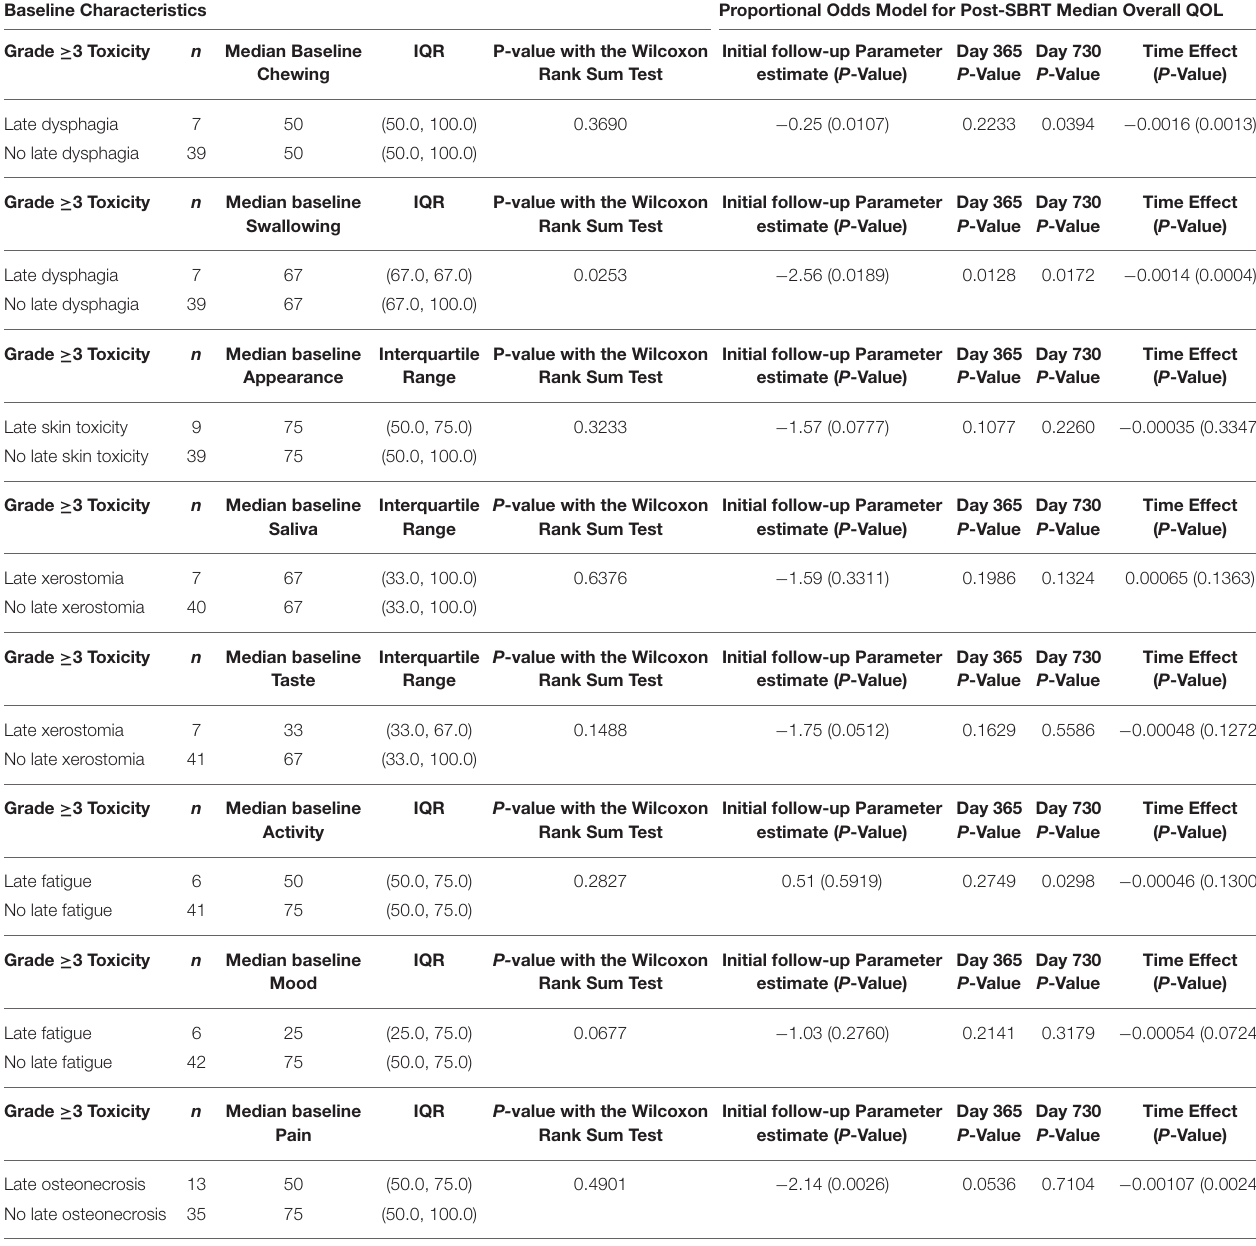
TABLE 4 | Effects of Grade ≥ 3 Late Toxicity on Specific QOL Domains. Baseline